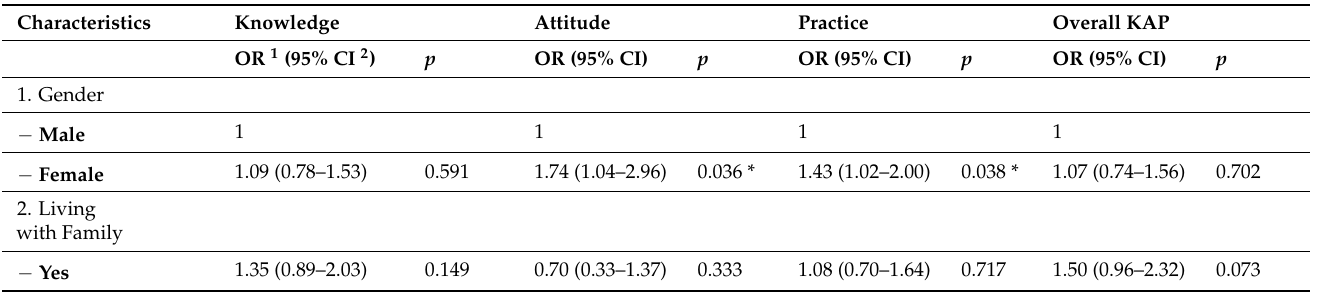
Table 6. Univariate analysis predictors of knowledge, attitude, practices, and overall KAP level towards dengue fever among university students of Dhaka City,